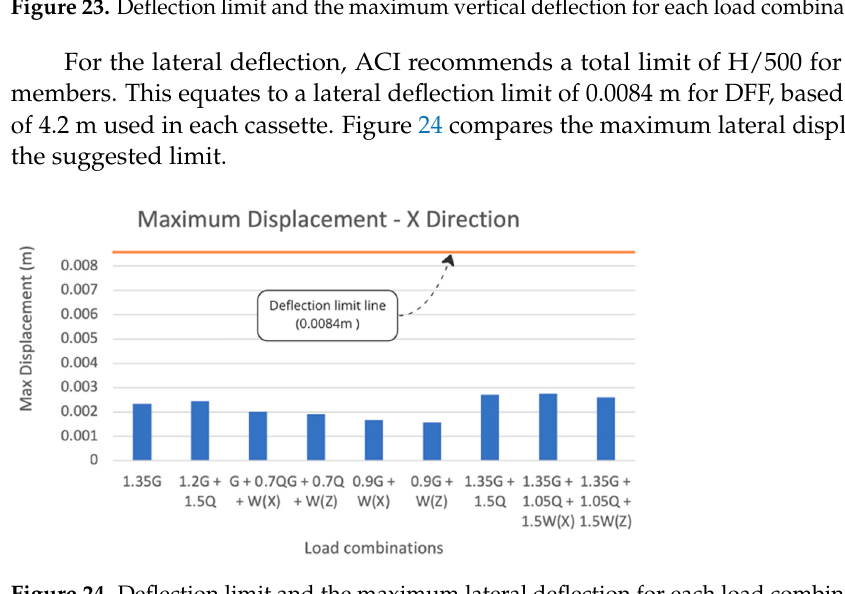
Figure 24. Deflection limit and the maximum lateral deflection for each load combination for DFF.